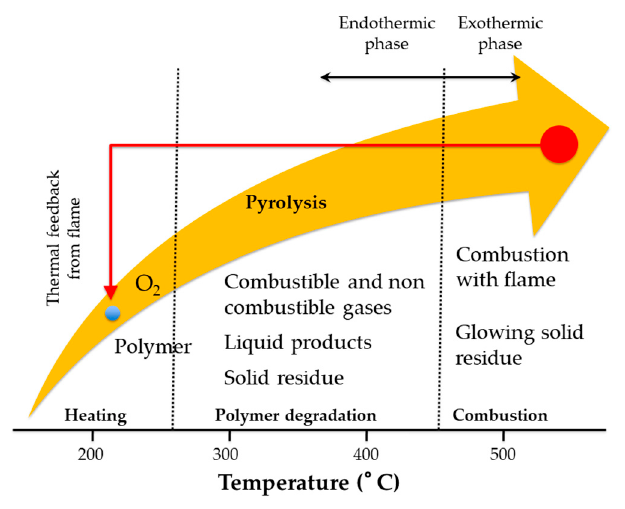
Figure 6. Schematic representation of polymer combustion process.